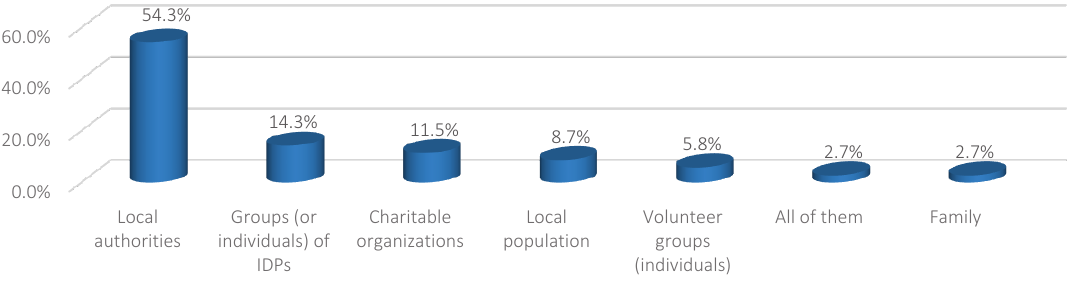
Figure 6. Support of IDPs in Pidberiztsivska community, % of